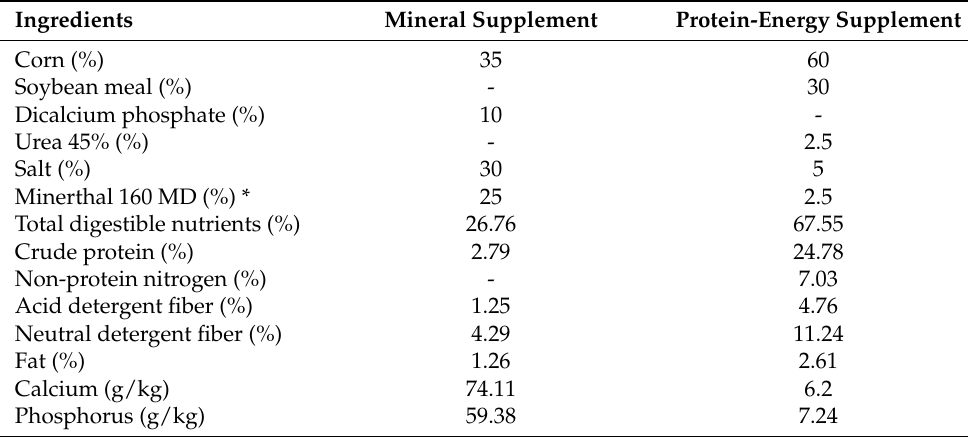
Table 1. Ingredients and nutrient content of the dams’